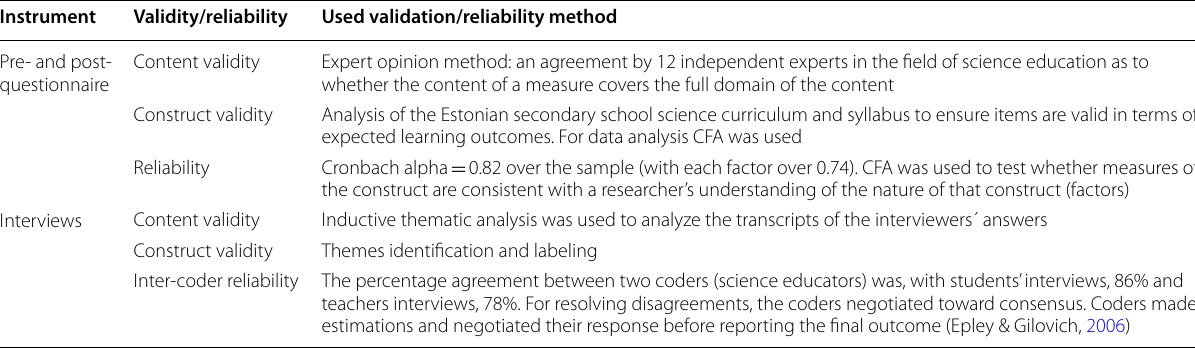
Table 5 Validation and reliability of the created instruments for this research